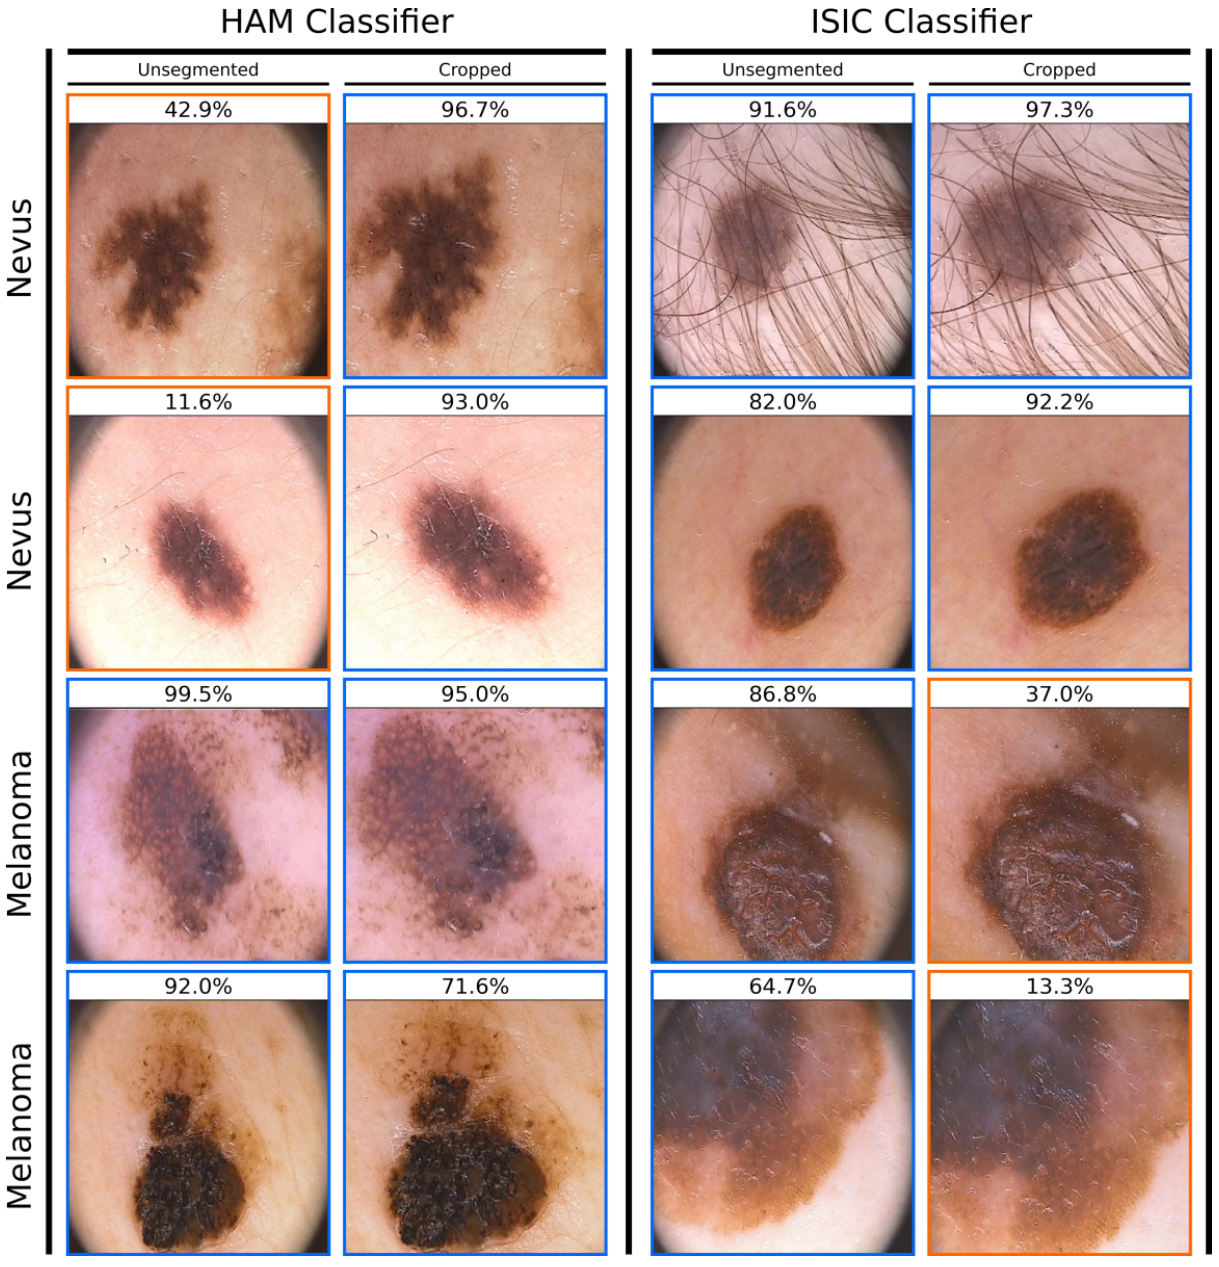
Figure 3. Exemplary predictions of a classifier trained on unsegmented HAM (left) and ISIC (right) images and evaluated on unsegmented and cropped PH2 images. The target class (ground truth) for each lesion is displayed to the left, with the classifier’s output probability for the target class on top. An output probability larger than 50% corresponds to a correct classification, which is also indicated by a blue frame, whereas an orange frame denotes an incorrect classification. HAM: human against machine data set; ISIC: international skin imaging collaboration data set; PH2: hospital Pedro Hispano data